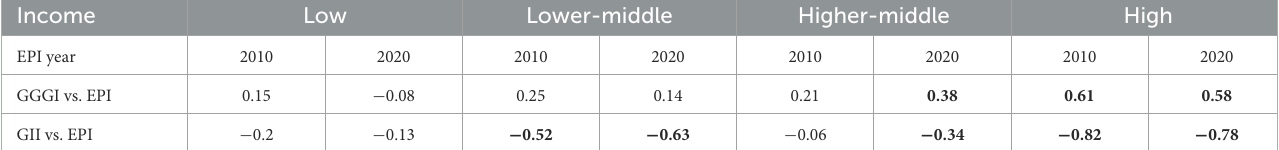
TABLE 3 Correlation coefficients between GGGI and EPI and between GII and EPI for each income category, using EPI composite scores for 2010 and 2020.